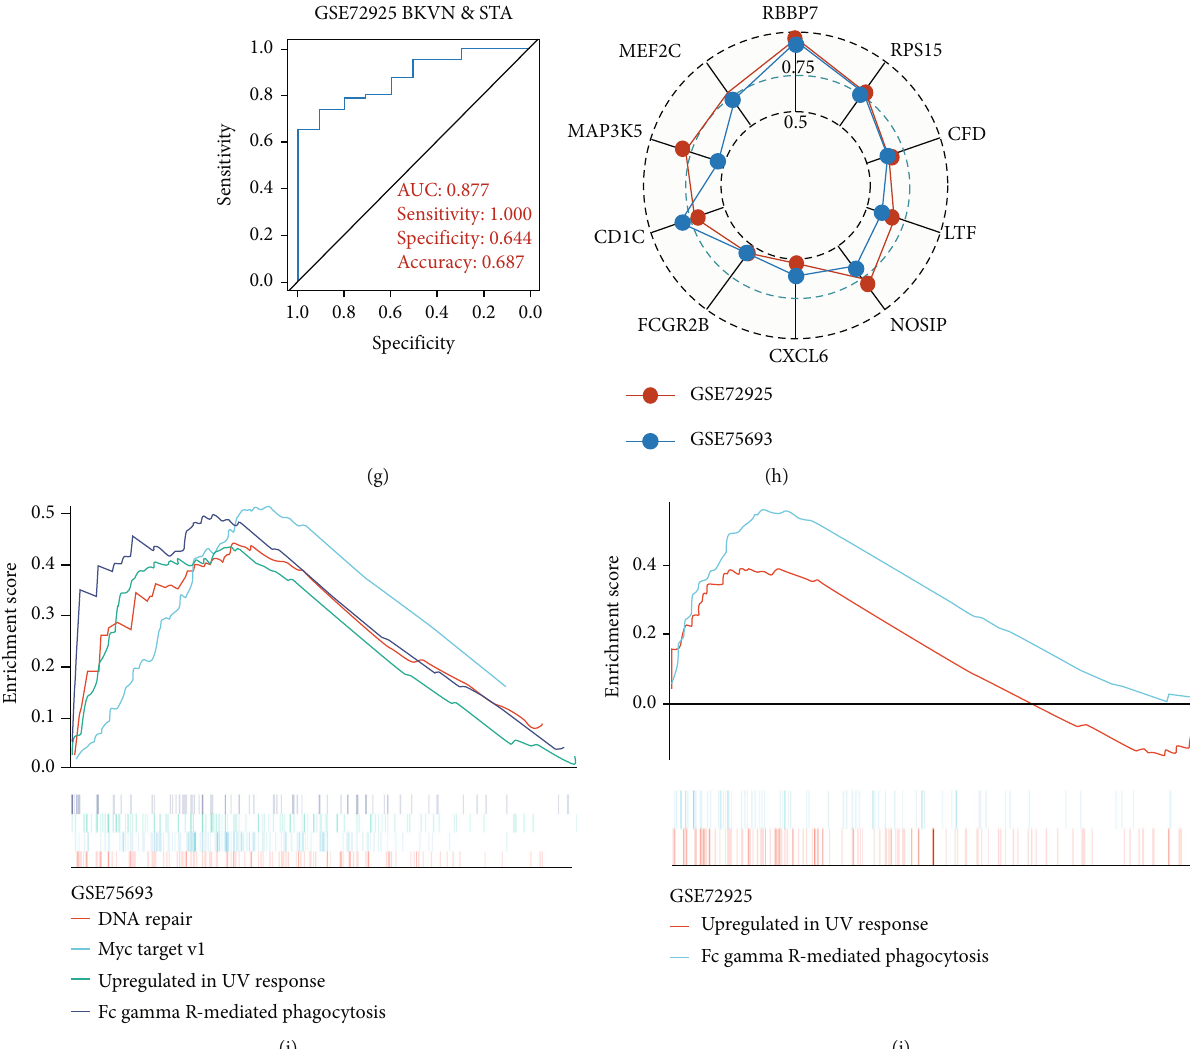
Figure 5: Selection and validation of the diagnostic gene. (a) Horizontal bar chart shows genes ranked by SVM-RFE. Red bars and blue bars represent the top-ranked 5 genes in comparison to AR and STA samples, respectively. (b and c) Violin plots show di ff erences in expression levels of RBBP7 among three types of allografts in the training and validation cohorts. (d and e) ROC curves show the diagnostic ability of RBBP7 between BKVN and rejection samples in the training and validation cohorts. (f and g) ROC curves show the diagnostic ability of RBBP7 between BKVN and STA samples in the training and validation cohorts. (h) Radar chart shows the AUC of RBBP7 and other previously reported genes for BKVN diagnosis in training and validation cohorts. (i and j) GSEA re fl ects pathways enriched in BKVN samples with higher expression levels of RBBP7 in training and validation cohorts. TCMR: T cell-mediated rejection. ROC: receiver- operating characteristic. AUC: area under the curve. ∗∗ P < 0 : 01 ; ∗∗∗ P < 0 : 001 ; ∗∗∗ ∗ P < 0 : 0001 , ns: not statistically signi fi